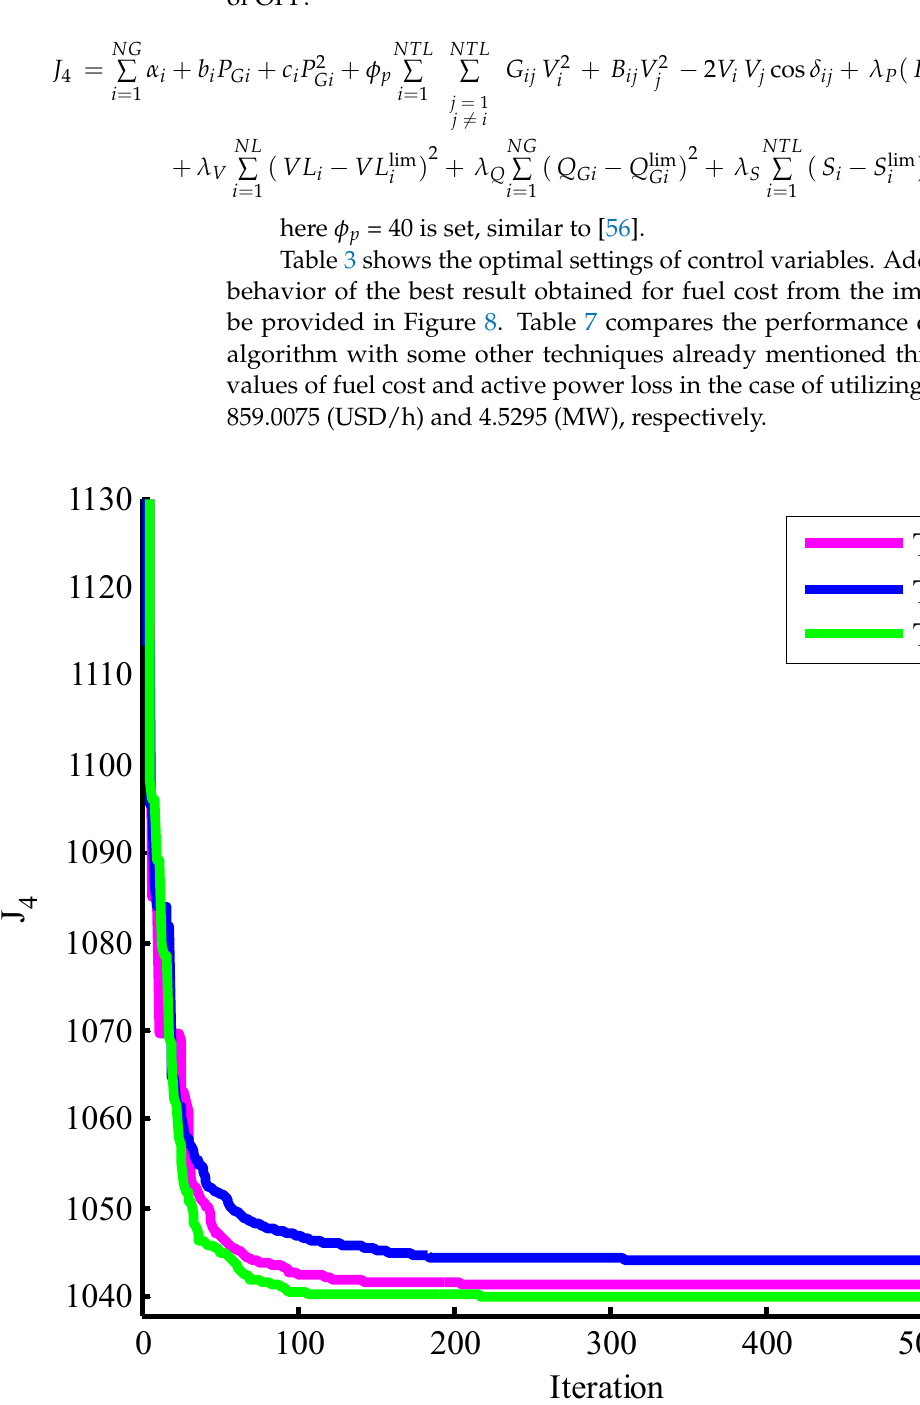
Table 7. Optimal results of the present study in Case 4. Optimizer